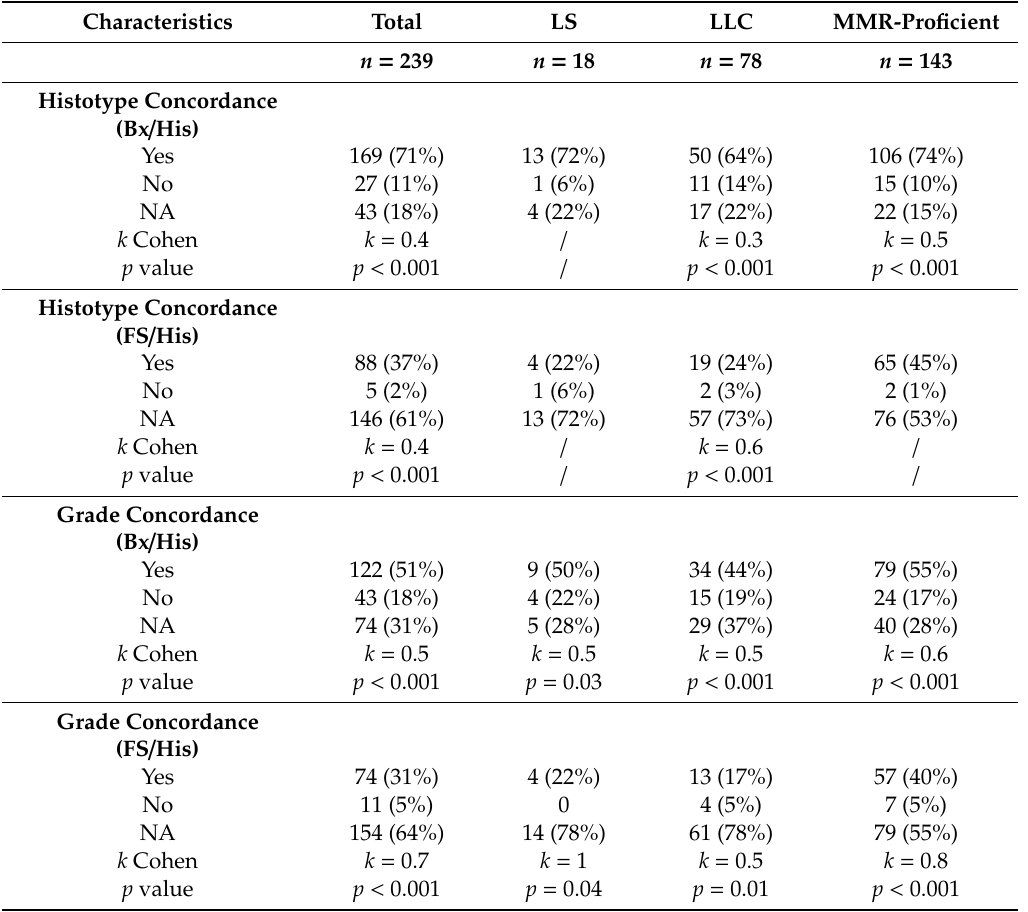
Table 4. Concordance between pre-operative biopsy and final histology for histotype and grade and concordance between frozen section and final histology for